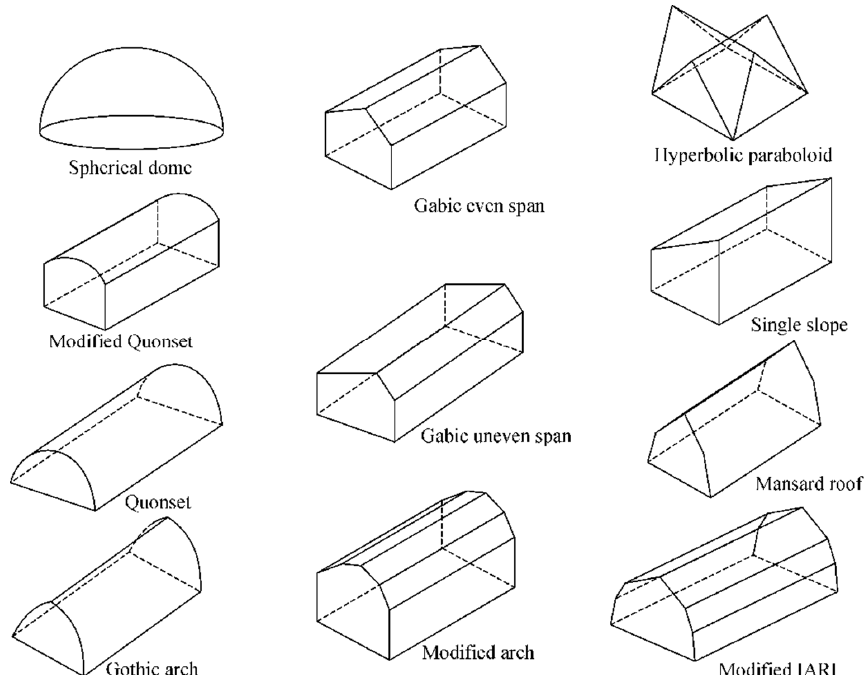
Figure 2. Different shapes of greenhouses [11]. Figure 2. Di ff erent shapes of greenhouses [11].